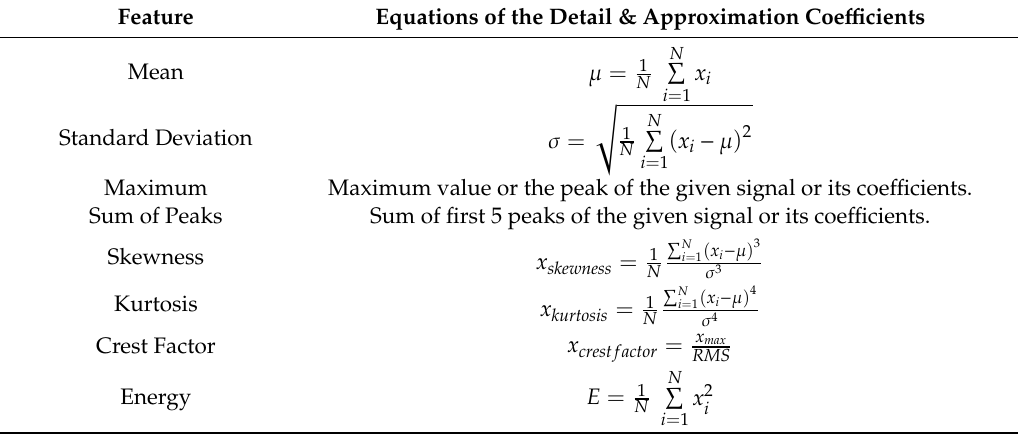
Table 3. Description and formulae for important statistical